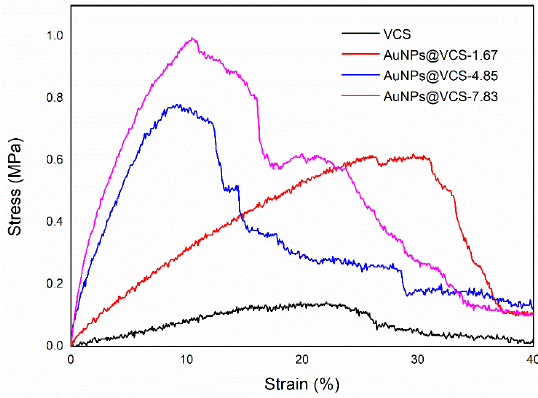
Figure 6. Strain–stress curves for extension test of VCS and AuNPs@VCS at room temperature.